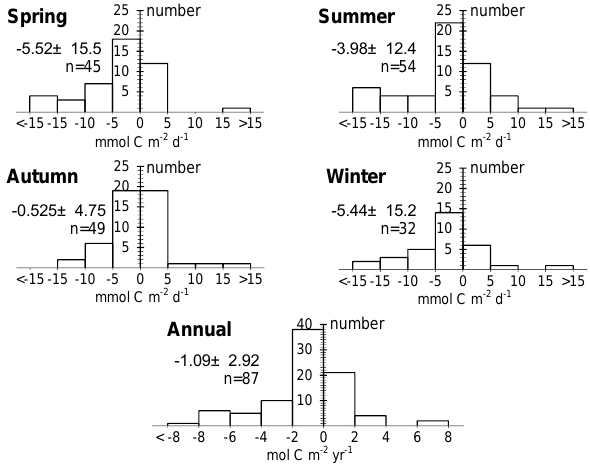
Fig. 9. Histogram of reported daily CO 2 fluxes in different seasons and annual flux on the world’s continental shelves.